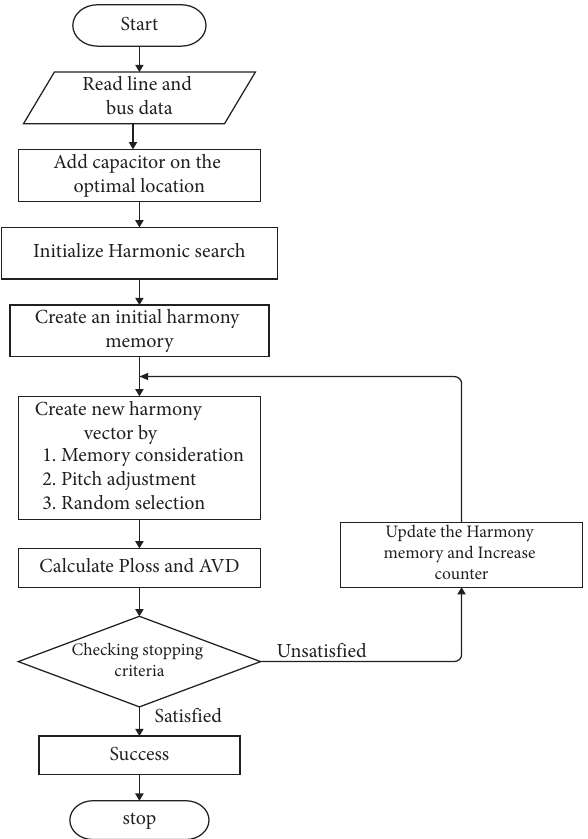
Figure 4: Harmony search algorithm flowchart